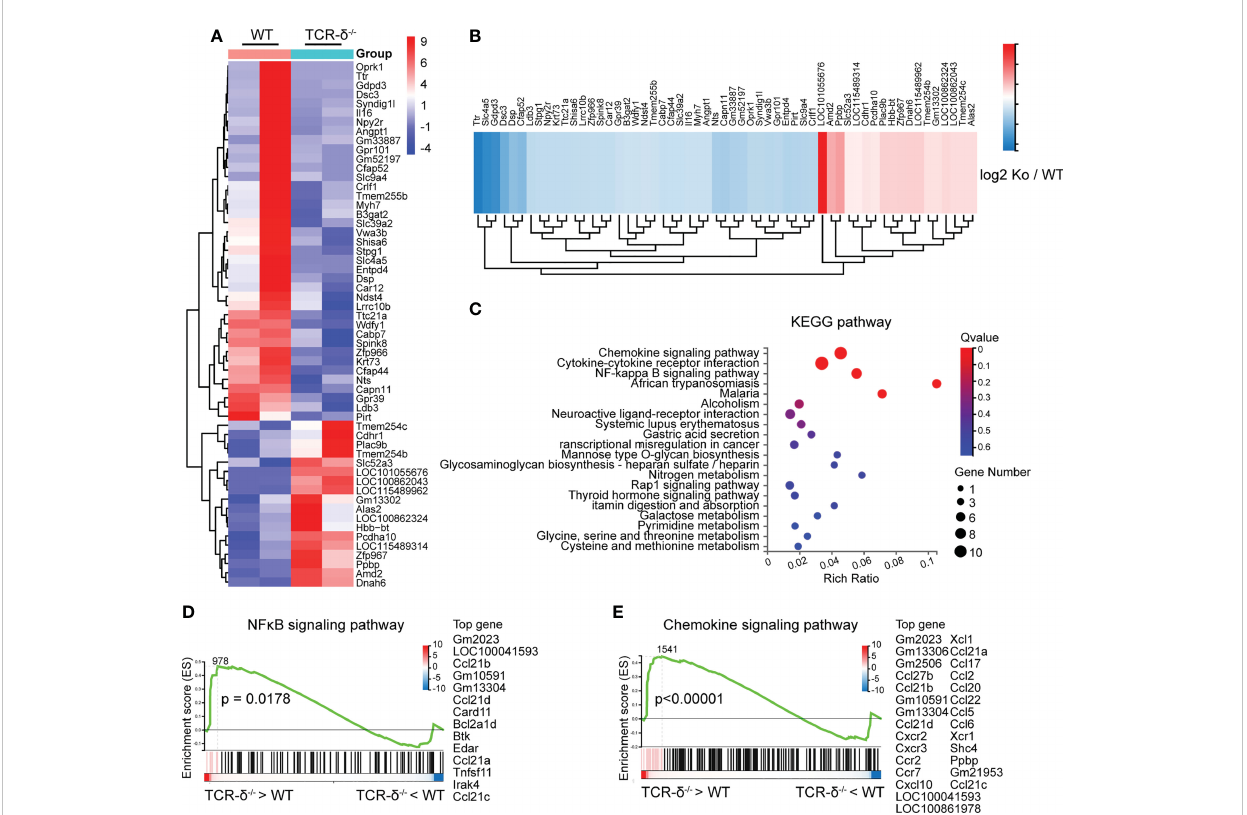
FIGURE 4 gd T cells de fi ciency enhances in fl ammatory signaling pathways after CMBs. RNA-seq of peri-CMBs cortical samples from WT and TCR- d -/- mice at 5 dpi. (A) Heatmap of gene expression in two groups. (B) Heatmap showing fold changes of differentially expressed genes between two groups. (C) KEGG pathway analysis of differentially expressed genes. (D, E) Gene set enrichment analysis (GSEA) showing the upregulation of NF k B and chemokine signaling pathways in TCR- d -/- mice compared with WT mice (n=4 mice, 2 mice in one sample, P value of log2 (ko/wt) <